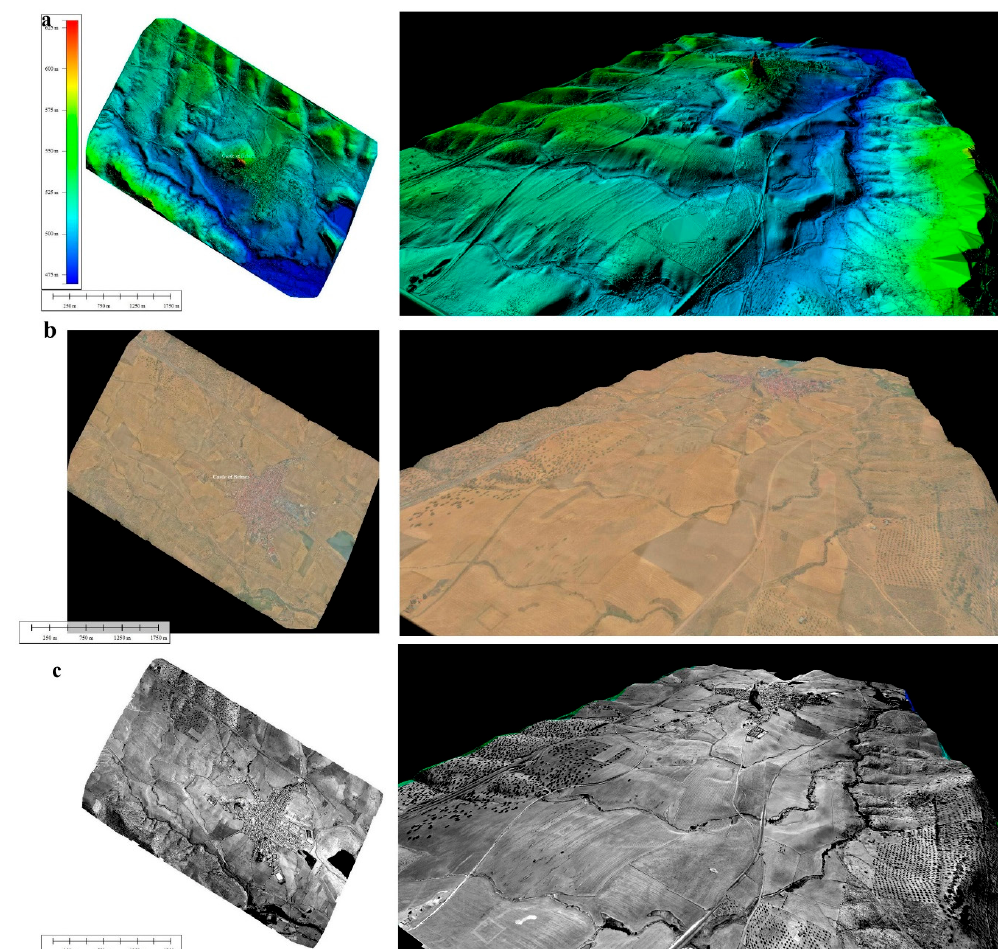
Figure 8. Figure 8. Results of the ortophogrammetric acquisitions of the area surrounding the CCB: ( a ) DTM; ( b ) RGB sensor; ( c ) thermal sensor. Taken from Quantalab-IAS/CSIC and ZNIR for “Ager ( a ) DTM; ( b ) RGB sensor; ( c ) thermal sensor. Taken from Quantalab-IAS / CSIC and ZNIR for Mellariensis”/AEI FEDER HAR 77136-R. “Ager Mellariensis” / AEI FEDER HAR